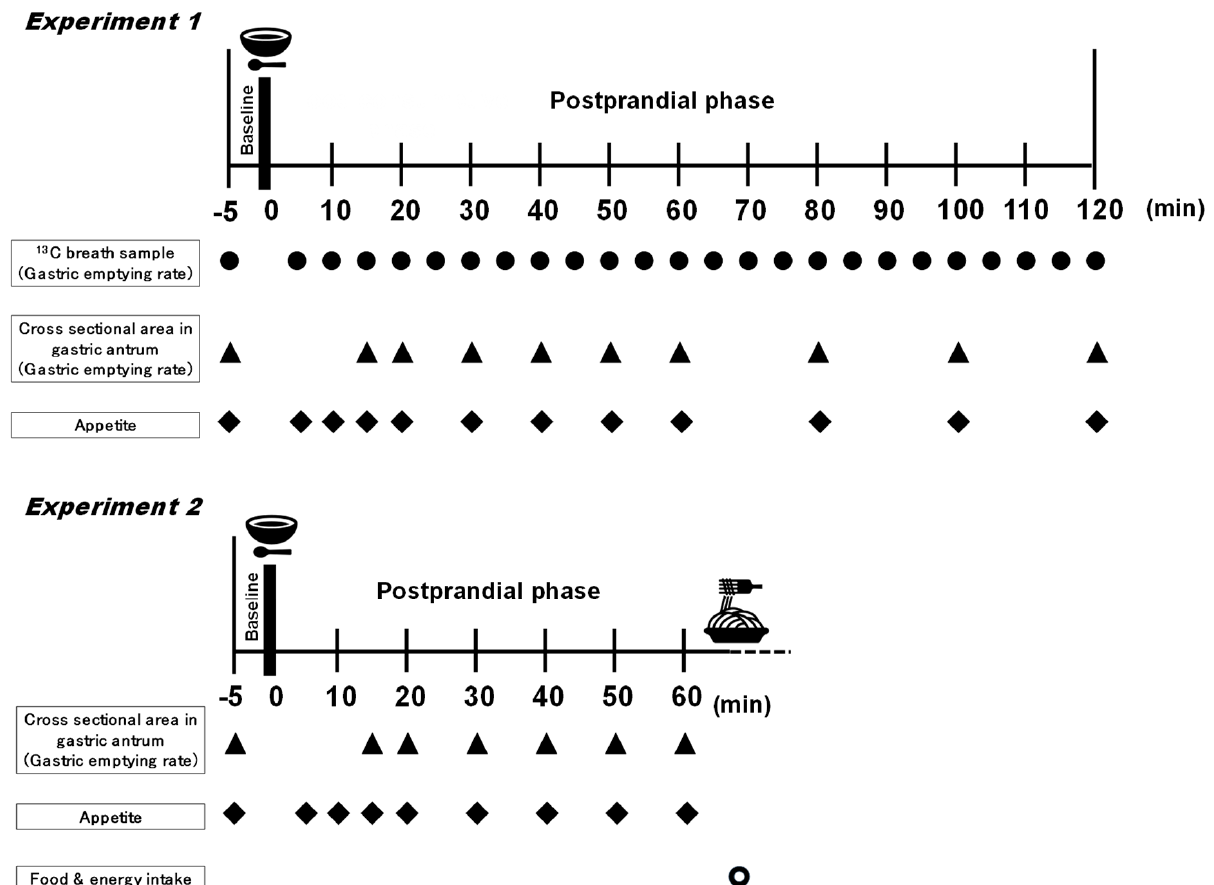
Figure 1. Scheme of the protocol of the study. In Experiment 1, following fasting baseline measurements for 5 min, the subjects were instructed to consume a 240 g pumpkin soup containing 9.2 g either intact corn oil (CO trial) or heated corn oil (HO trial) for 1–2 min, and then rested for 120 min. In Experiment 2, the subjects were instructed to consume a 240-g pumpkin soup containing 3.1 g of either non-heated corn oil (CO trial), heated corn oil (HO trial), or intact corn oil with added 1 mg 2,4-DD (2,4-DD trial) for 1–2 min, and then rested for 60 min. At 60 min after the consumption of pumpkin soup, cod roe spaghetti was given, and the participants were instructed to eat as much as they like until satisfied.